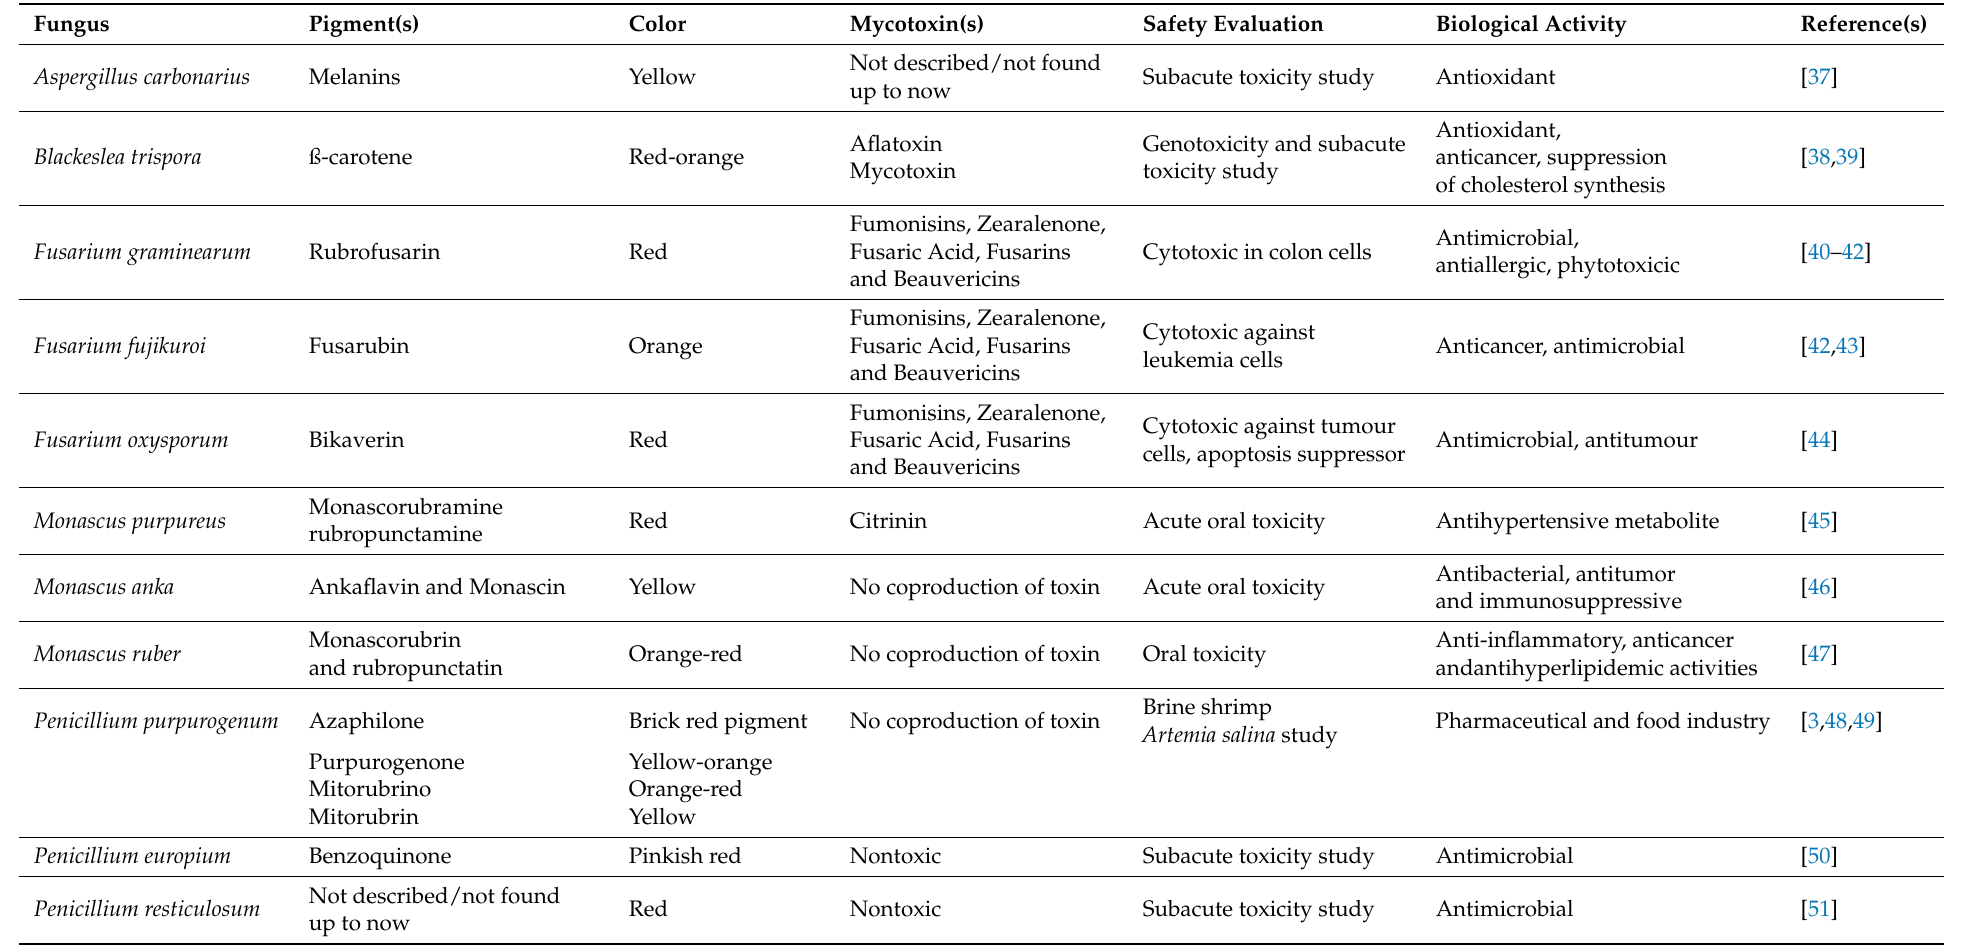
Table 1. Important fungal pigments and their safety